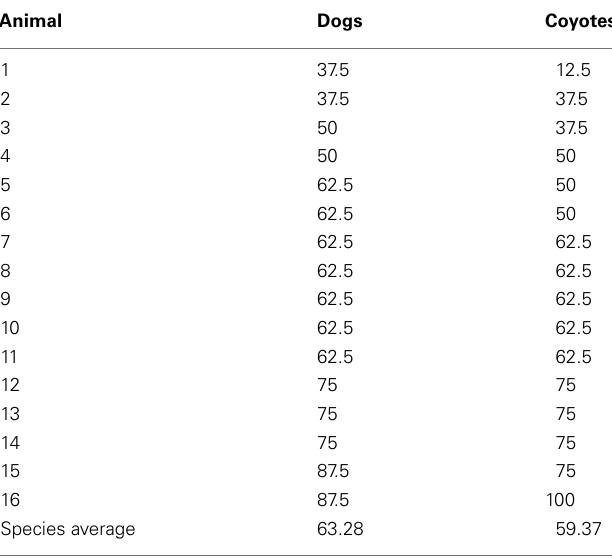
Table 1 |Average percentage of times choosing the large option across all ratios for each individual dog and